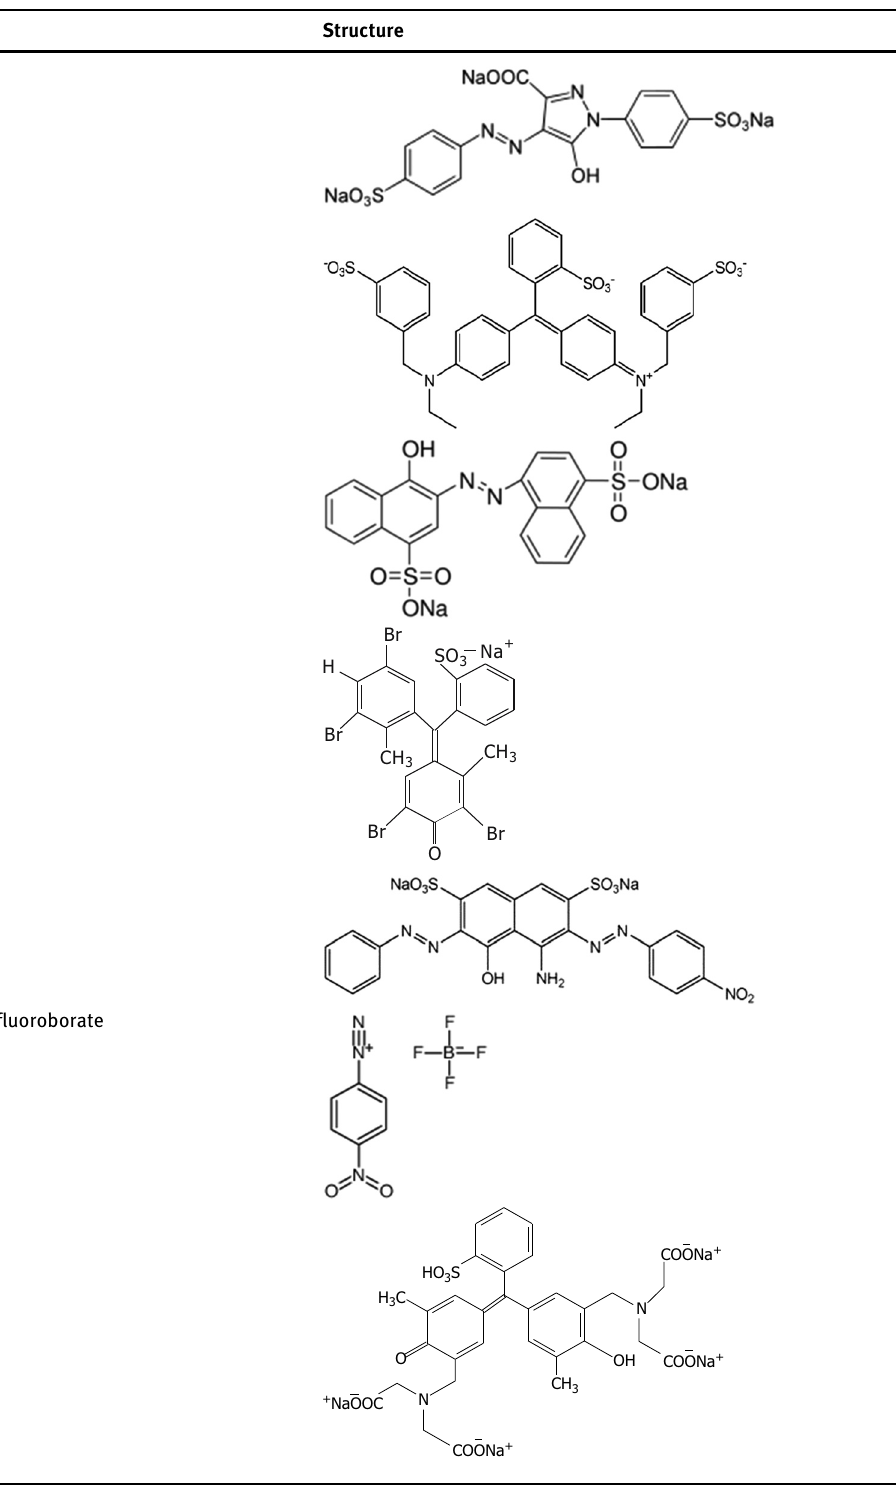
Table 1: Structure of organic dyes [ 34 ]